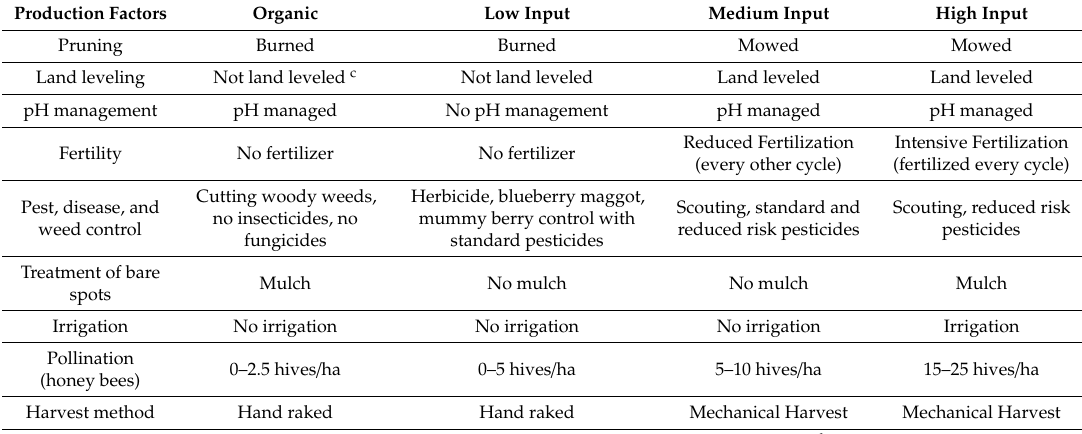
Table 2. Typical a inputs associated with the four wild blueberry production management systems b